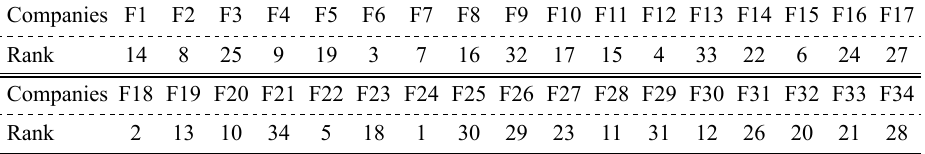
Table 3. Sensitivity analysis results based on a hybrid TOPSIS model for